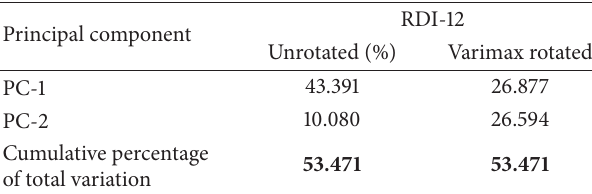
Table 3: Explained variance (%) by the loadings with and without rotation for the RDI-12 during 1960–2010.